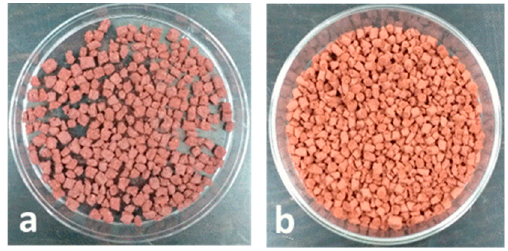
Figure 1. ( a ) Fe 2 O 3 -based pellets in square blocks. ( b ) Fe 2 O 3 -based pellets in cylinders.